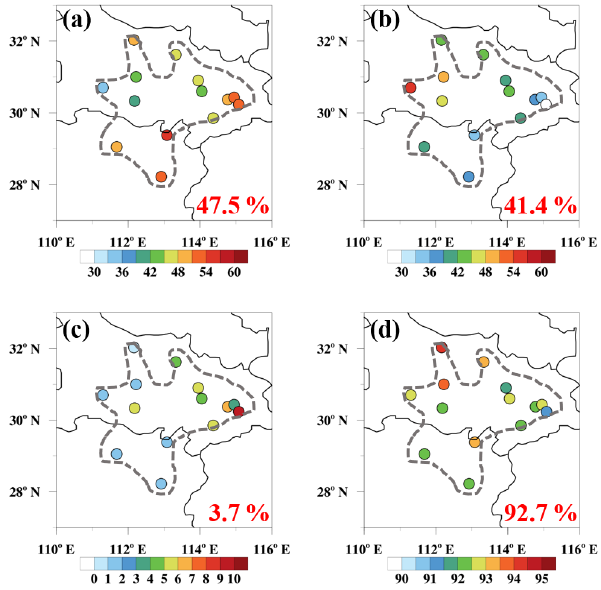
Figure 2. Spatial distributions of the (a) short-term, (b) seasonal and (c) long-term components, and (d) total contribution to the total variances of daily PM 2 . 5 changes observed at 14 sites in the THB with regional averages of 47.5%, 41.4%, 3.7% and 92.7%, respec-